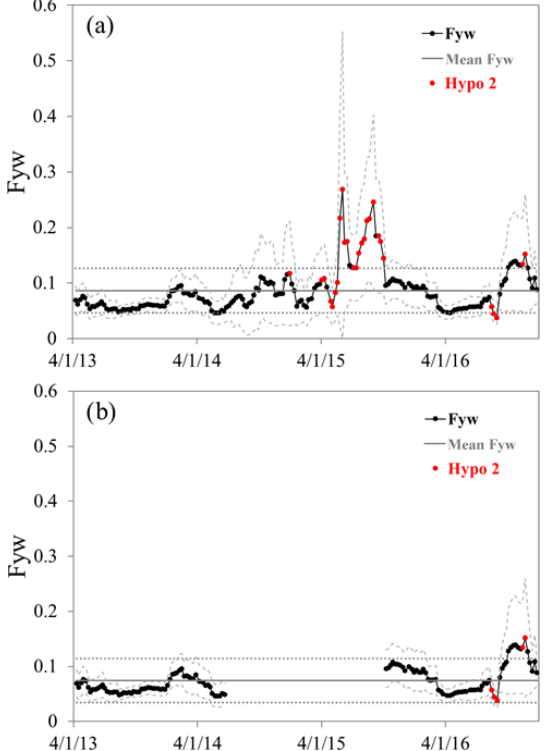
Figure 6. Fyw(189) compared to the mean Fyw (solid grey line) and a ± 0 . 04 margin around it (dotted grey lines) to test hypothe- sis 1 (90% of all Fyw results are within the mean Fyw ± 0 . 04). Red data points are periods where within 4 weeks, Fyw differed by more than 0.04 (testing hypothesis 2). Once all data were used (a) , subse- quently data of the low R 2 period between July 2014 and October adj 2015 were left out (b)